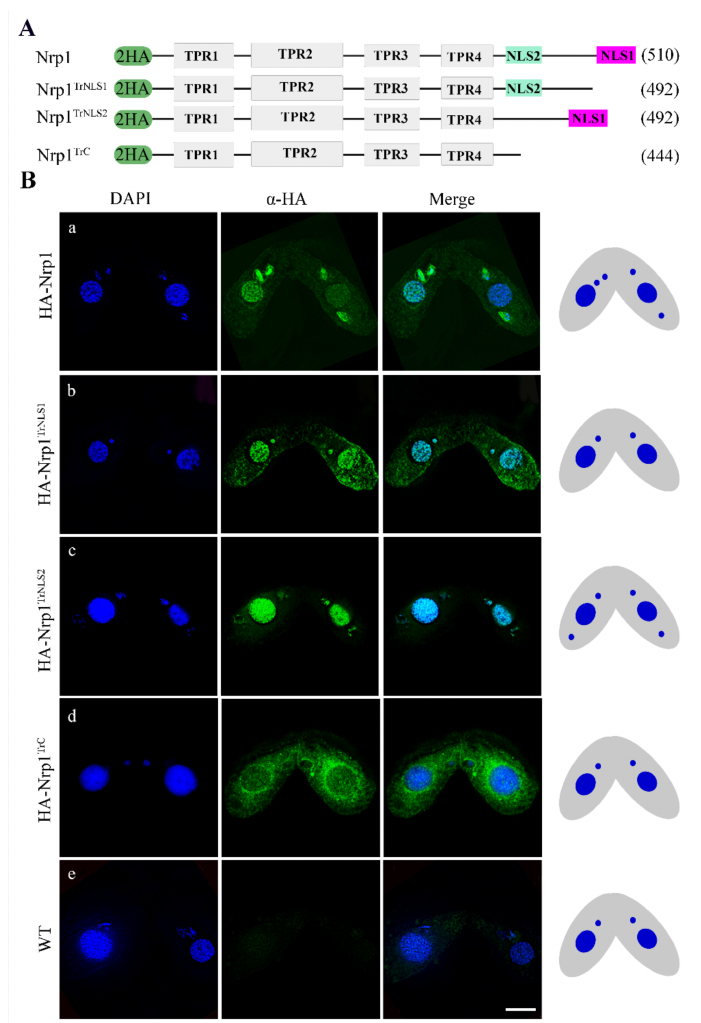
Figure 1. Localization of Nrp1 mutants. ( A ) Schematic representation of Nrp1, Nrp1 TrNLs1 , Nrp1 TrNLs2 , and Nrp1 Trc truncated mutants. ( B ) Localization of Nrp1 and Nrp1 mutants during conjugation stage: ( a ) HA-Nrp1, ( b ) HA-Nrp1 TrNLS1 , ( c ) HA-Nrp1 TrNLS2 , and ( d ) HA-Nrp1 TrC ; ( e ) WT cell is as negative